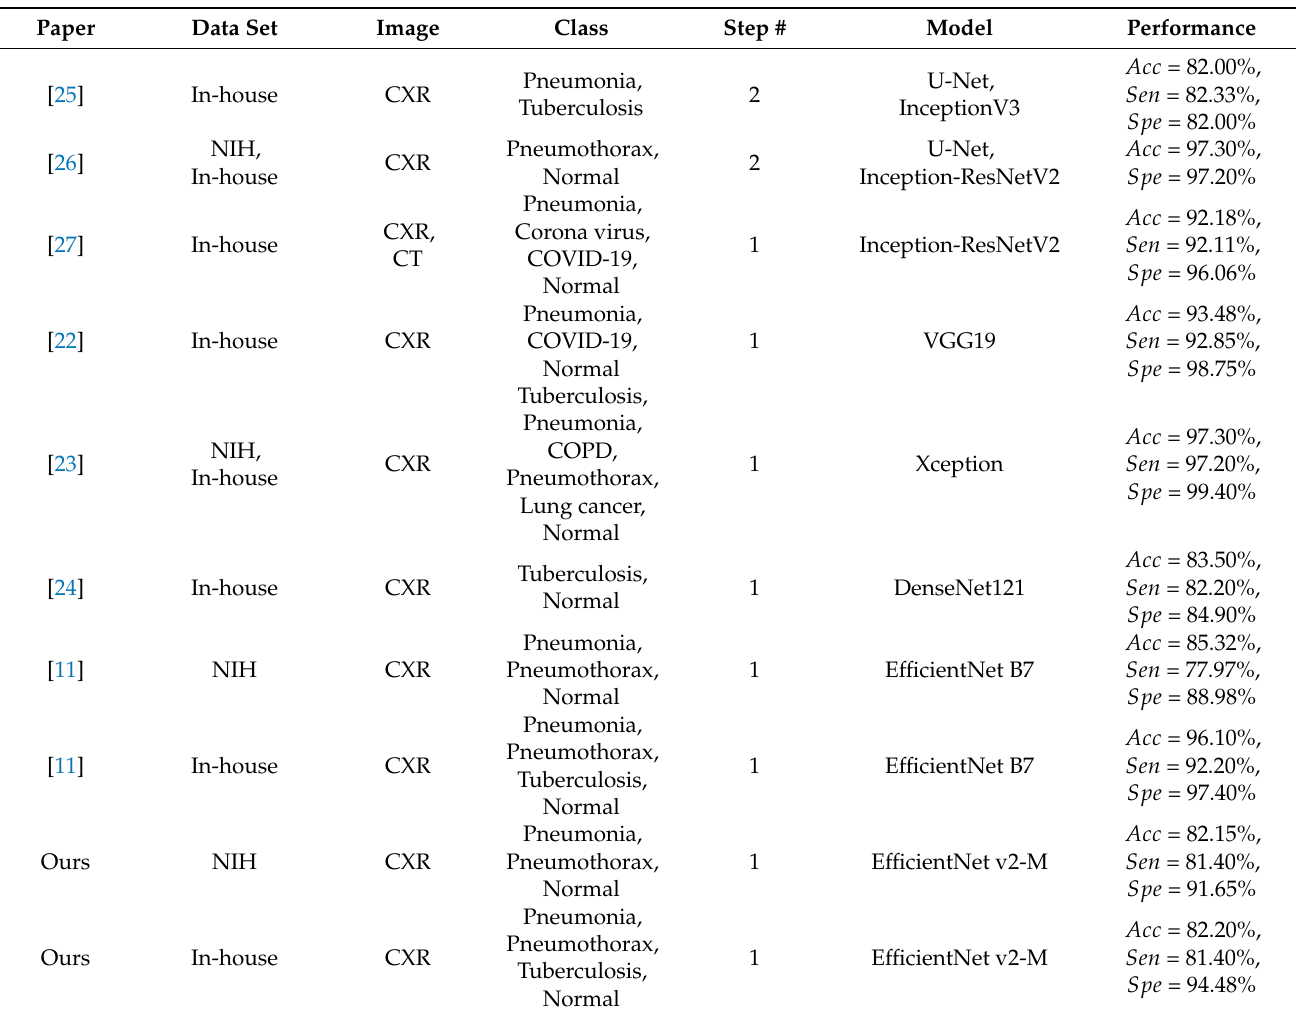
Table 12. Performance comparison on multi-class classification.